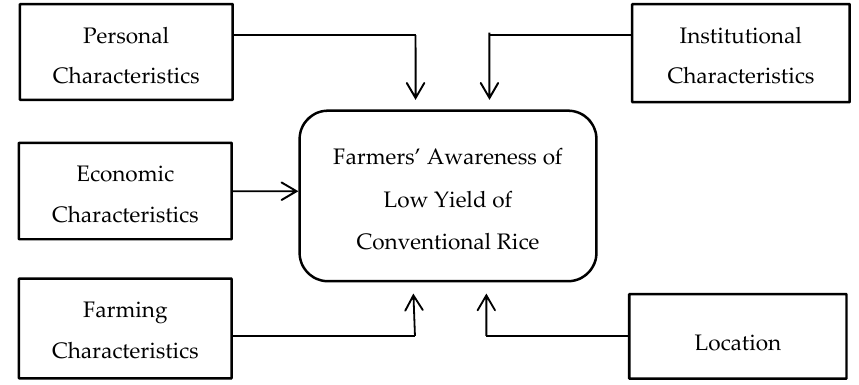
Figure 2. Conceptual framework of the study.